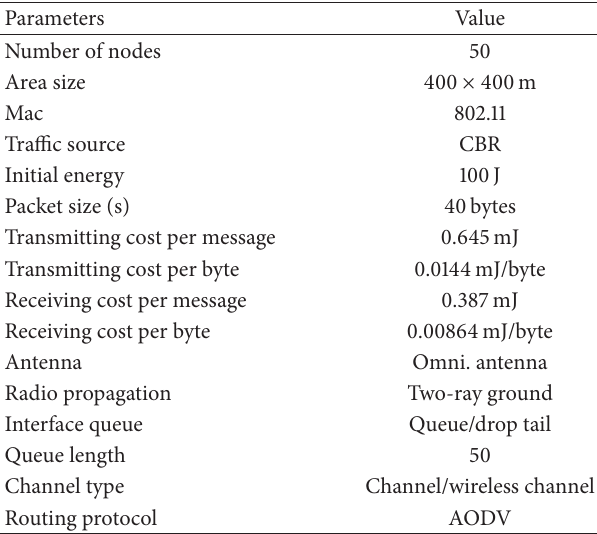
Table 1: Simulation